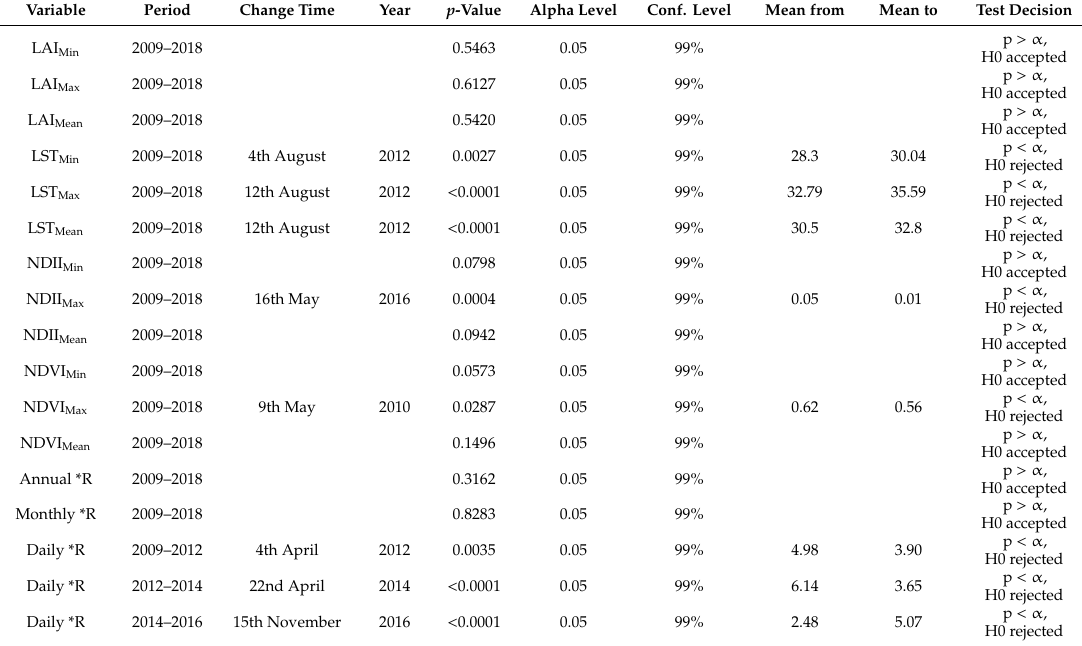
Table 6. Pettit test results for LAI, LST, NDII, and NDVI for the period 2009–2018 for study